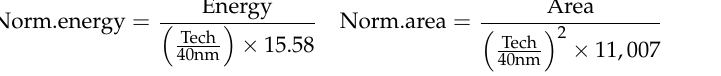
Table 5. Comparison of different multipliers in terms of energy per multiplication.